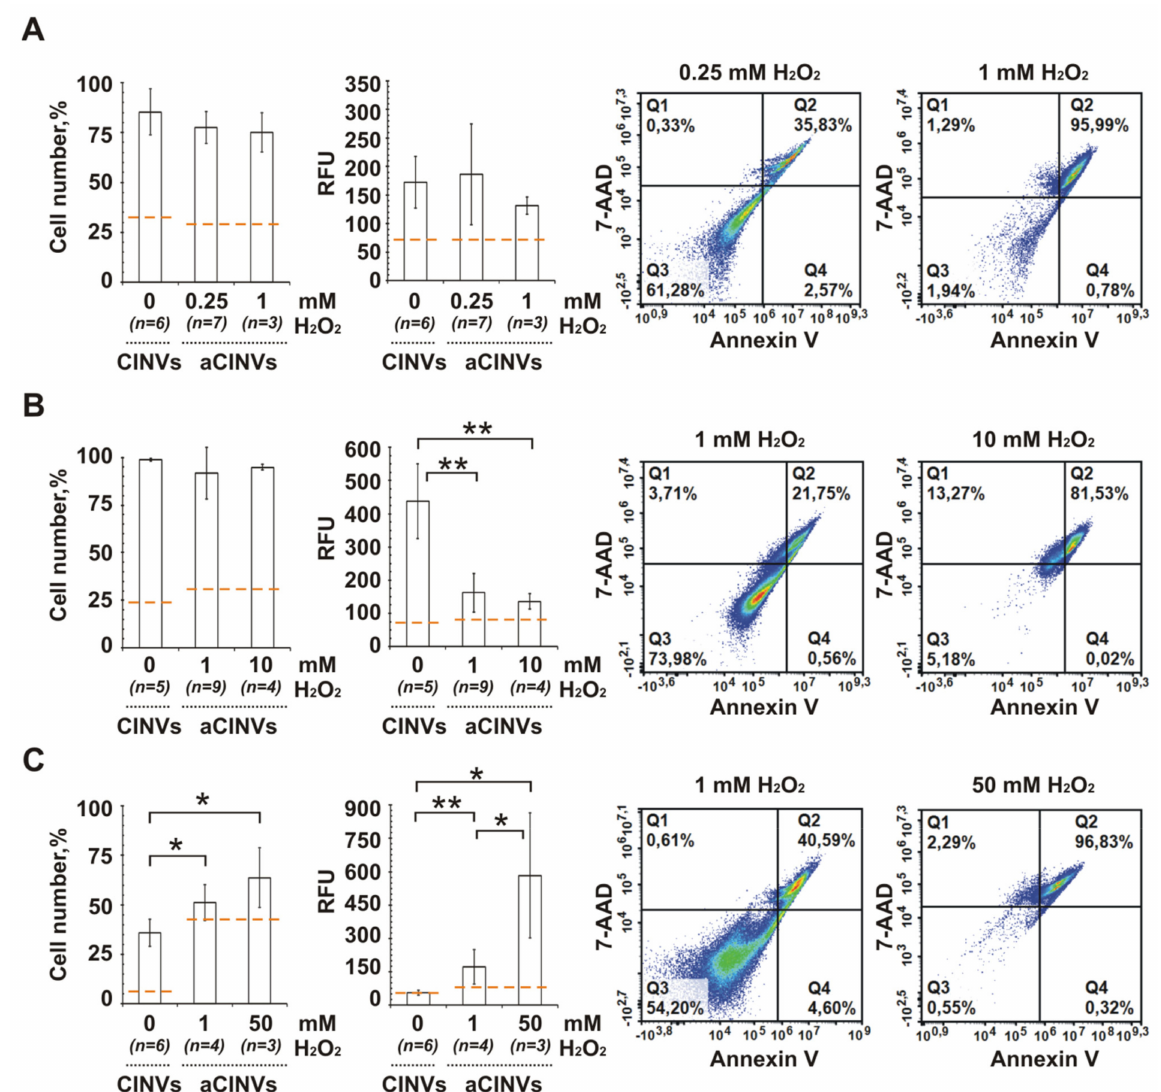
Figure 5. FAM-ON delivery into B16 ( A ), KB-3-1 ( B ), and K562 ( C ) cells mediated by CINVs derived from apoptotic cells (aCINVs). To prepare aCINVs, apoptosis was induced by cell incubation with H 2 O 2 for 24 h. These aCINVs are indicated on the histograms as used H 2 O 2 concentration. Data obtained for CINVs, derived from live cells, were used as a control. These CINVs are indicated as 0 mM H 2 O 2 . The histograms show the levels of FAM-ON accumulation in the cells mediated by 50 µ g aCINVs or CINVs. B16, KB-3-1, and K562 cells were treated with nanovesicles isolated from the same cell type. Cell number is the percentage of FAM-positive cells in a population. RFU is relative fluorescence units. The level of FAM-ON self-penetration into the cells (CTRO) is indicated by an orange dashed line. Flow cytometry two-parameter plots illustrate the level of cell death induced by H 2 O 2 ; cells were co-stained with Annexin V and 7-AAD. Quadrant 1 (Q1) shows necrotic cells. Quadrant 2 (Q2) shows late apoptotic/necrotic cells. Quadrant 3 (Q3) shows live cells. Quadrant 4 (Q4) shows early apoptotic cells. The number of measurements is indicated as n . Experimental data are presented as the mean ± SD. Statistical analysis was performed using the Mann–Whitney U test and was carried out between the CINV/aCINV’s experimental groups ( n = 3–9); * p ≤ 0.05, ** p ≤ 0.01. To induce cell death in B16 cells, they were pre-incubated with either 0.25 mM